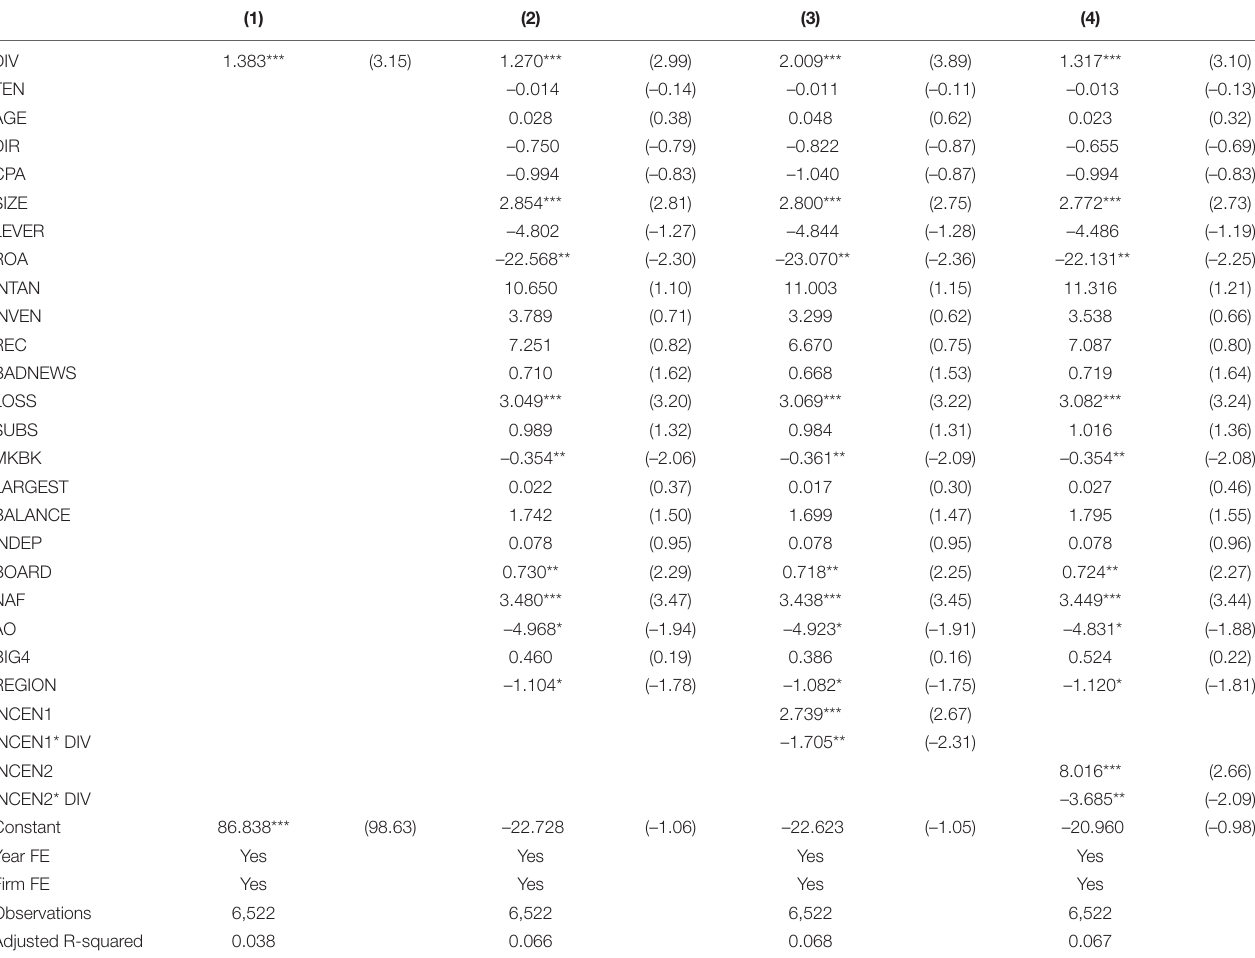
TABLE 4 | CFO functional diversity and timeliness for SOEs